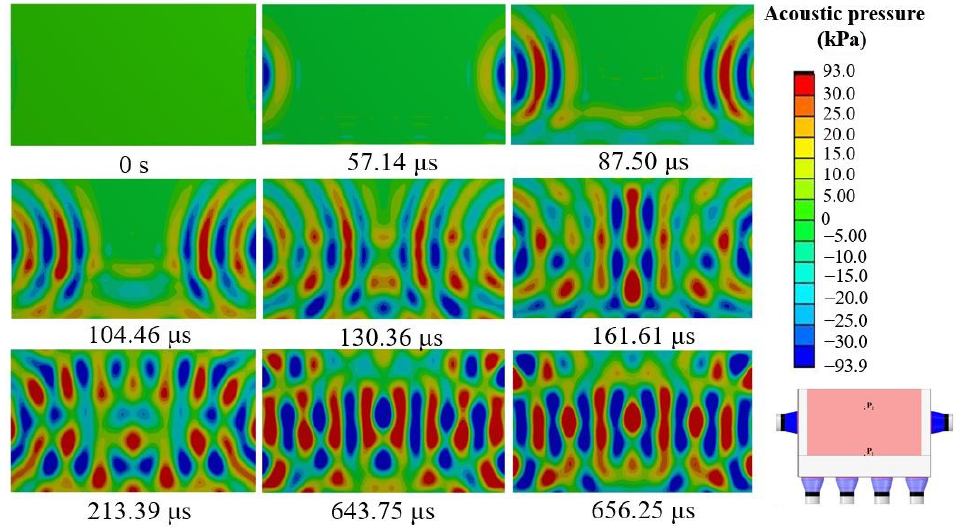
Figure 13. Acoustic pressure distribution in terms of time at S 1 for model B.